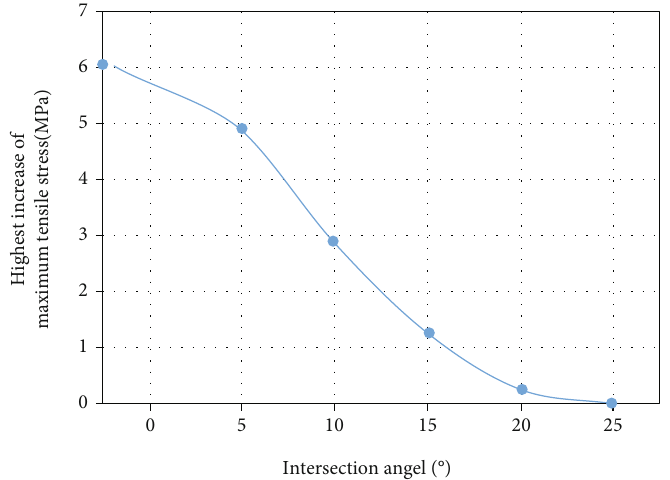
Figure 6: Highest increment of maximum tensile stress with di ff erent intersection angles.